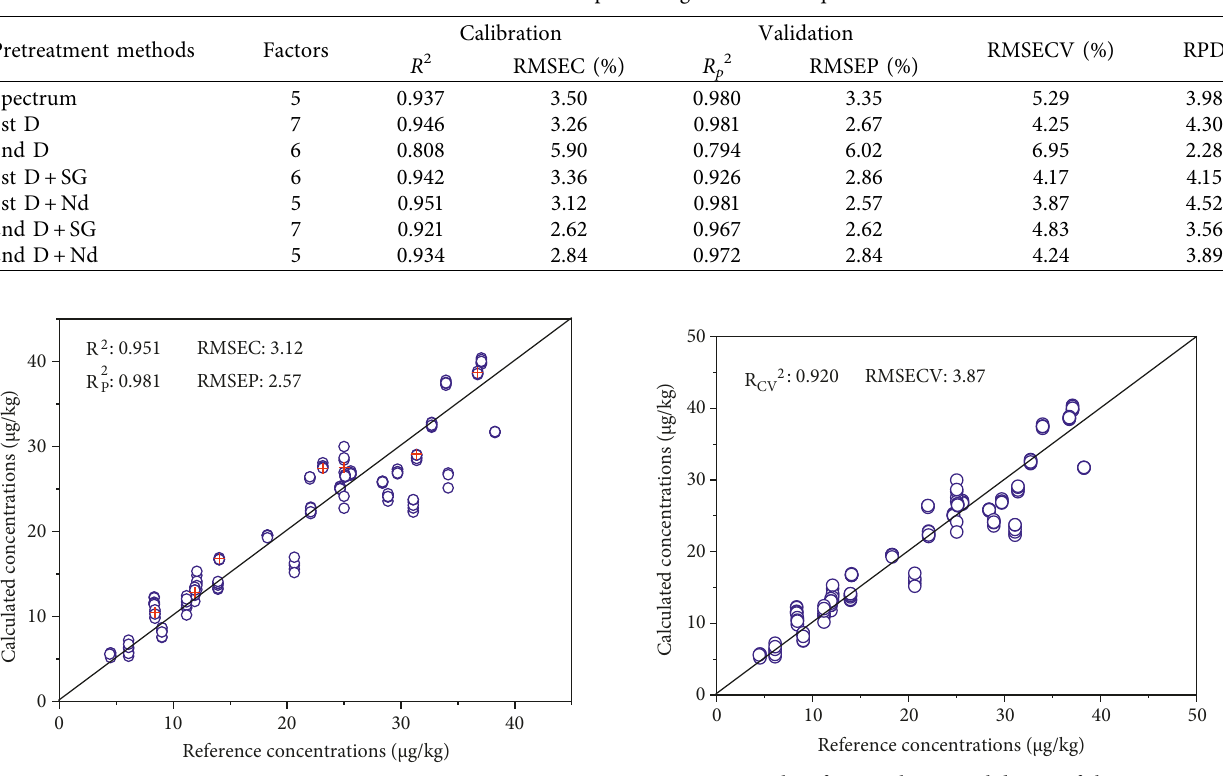
Table 3: Influence of the different data-processing methods on quantitative model.